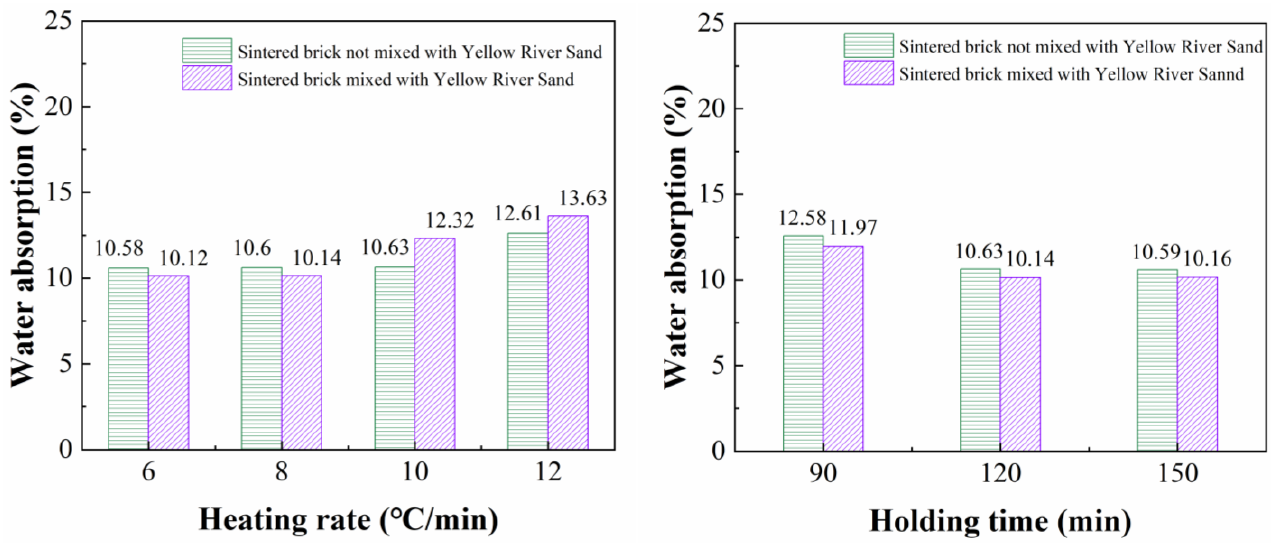
Figure 11. Effect of heating rate and holding time on water absorption of MGS sintered